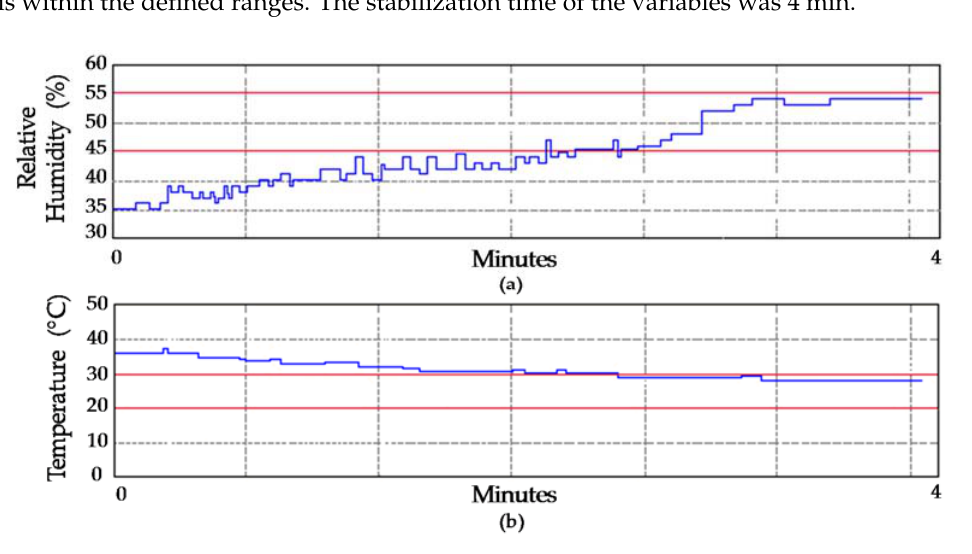
Figure 10. Results obtained when the temperature and relative humidity are outside the ranges defined by the set point. ( a ) Relative humidity. ( b ) Temperature.